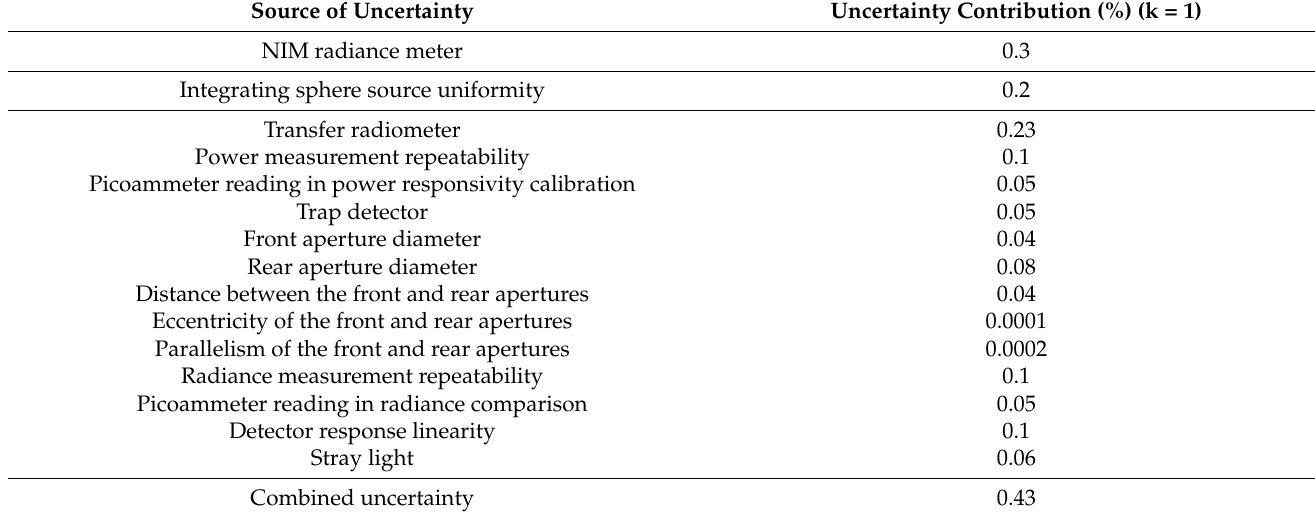
Table 6. Uncertainty for the radiance measurement comparison experiment of the transfer radiometer filter-free